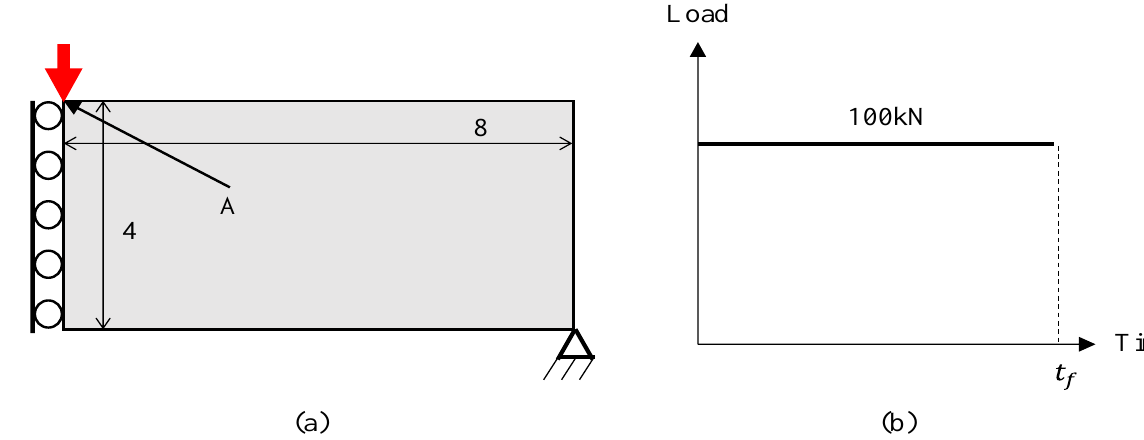
Figure 6. Problem definition for Michell-type structure problem: ( a ) schematic description ( b ) load condition.